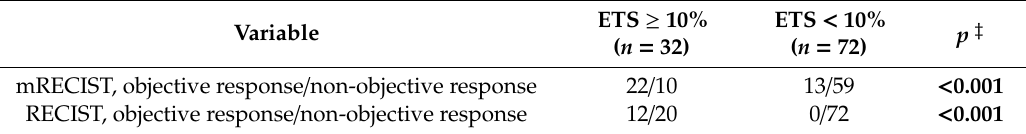
Table 5. The association between early tumor shrinkage and mRECIST- / RECIST-based objective response at the first evaluation † .